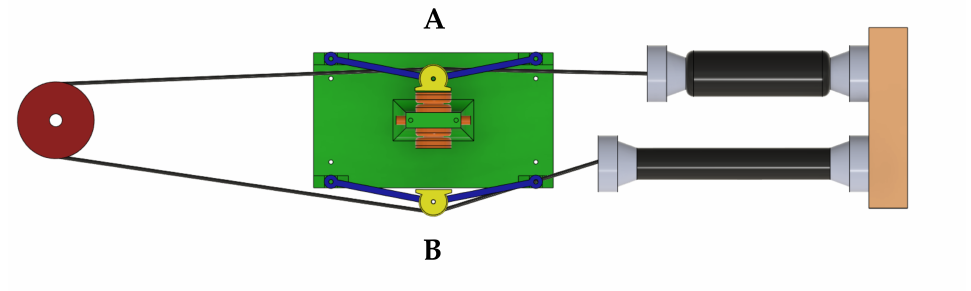
Figure 4. Regulation mechanism of the cables tension. The hybrid actuator enables the independent regulation of the joint cables, also in two complementary configurations: closed (point A at the internal position) and open (point B at the external position).